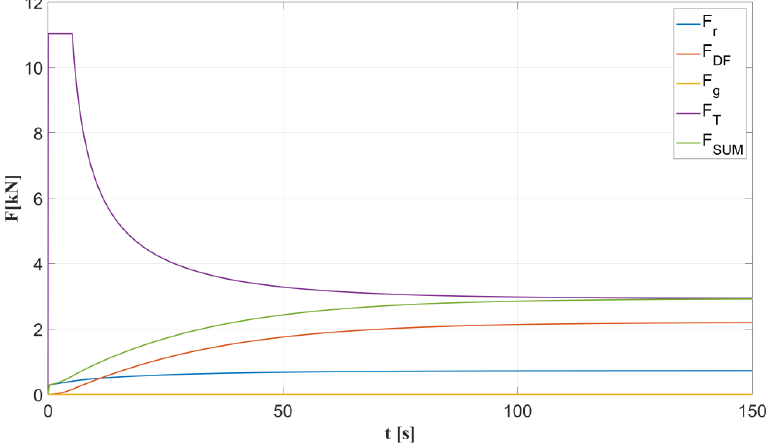
Figure 13. Forces acting on vehicle obtained from simulation results for 100 kW IPMSM.